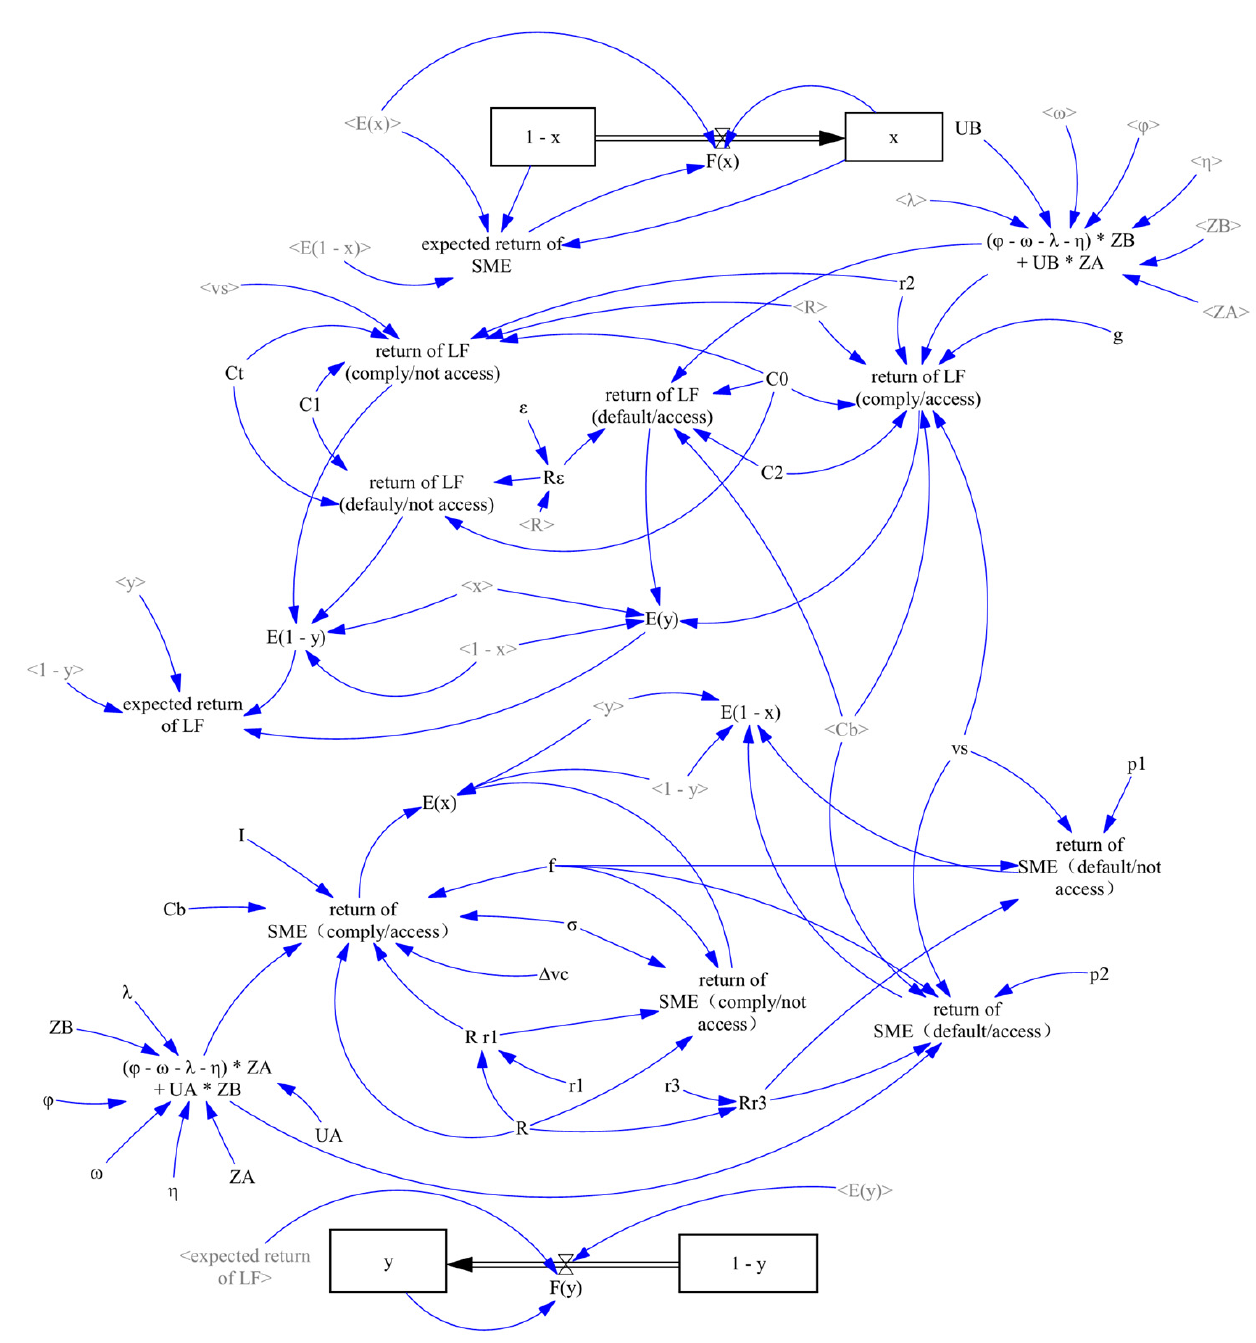
Figure 6. System dynamics model for the consortium blockchain-based leasing strategies.